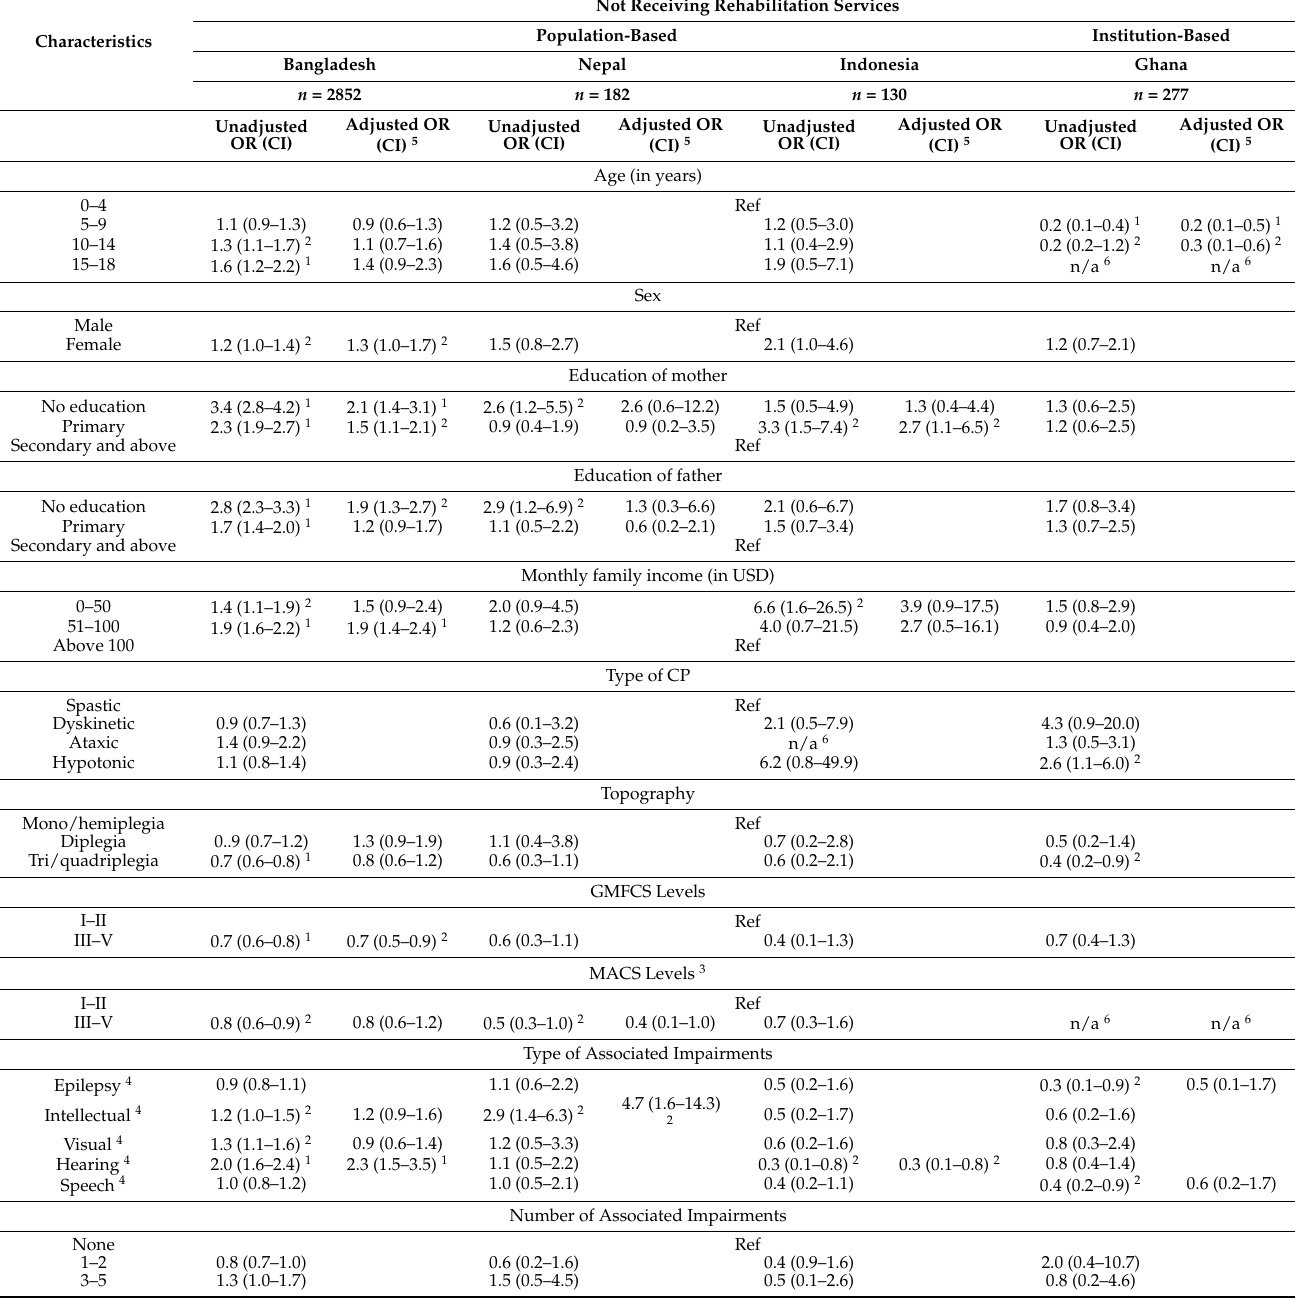
Table 5. Socio-demographic and clinical predictors of not receiving rehabilitation services among children with CP in Bangladesh, Nepal, Indonesia, and